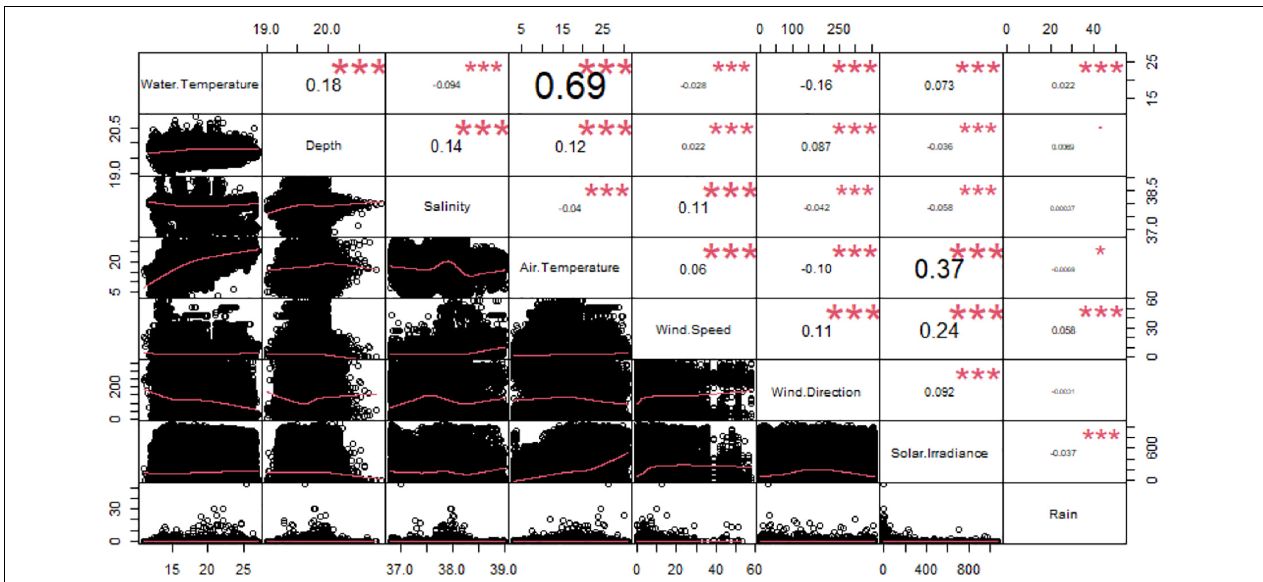
FIGURE 3 | Correlation chart among the environmental variables. The name of each variable is shown on the diagonal. Below the diagonal the bivariate scattered plots with the fitted line in red are displayed. Above the diagonal the value of the correlation plus the significance level as stars: to p -values of 0, 0.001, 0.1, 0.05, 0.1, and 1 correspond respectively “***”, “**”, “*”, “.”, and “”.